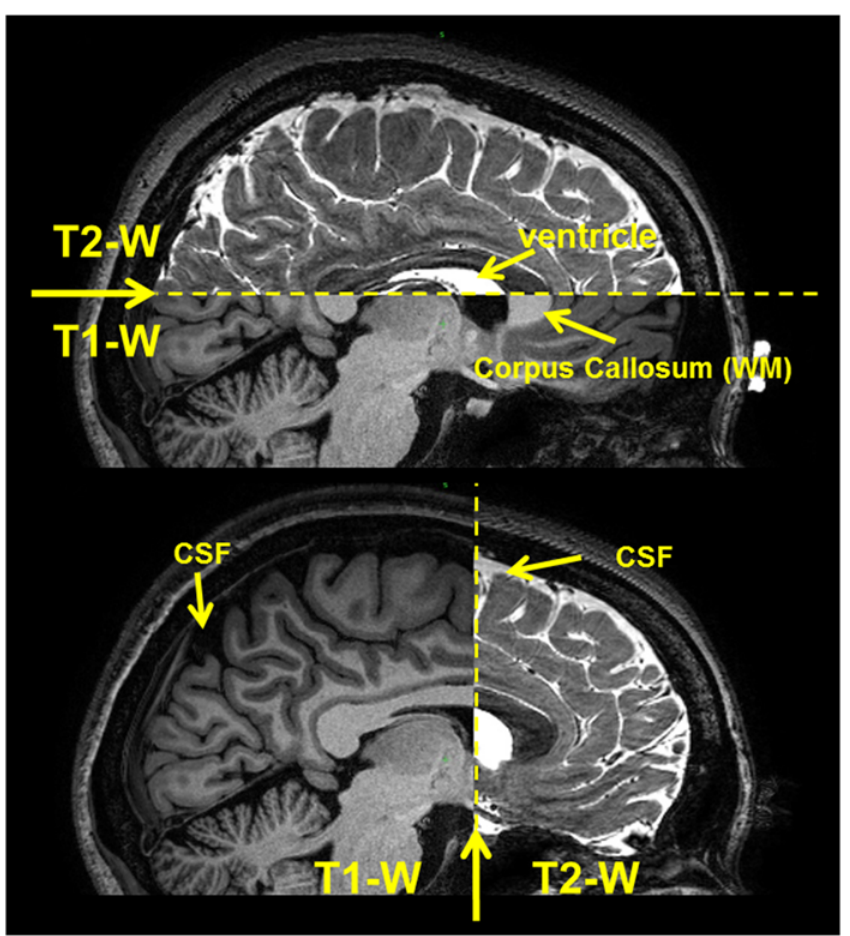
Fig 3. T1- and T2-weighted MRI registration. Sagittal view of the registered and integrated T1- and T2-weighted MRIs. The contrast between WM, e.g., corpus callosum, and GM signals is higher in T1, while the CSF, e.g., ventricle, is enhanced in T2. The tissue segmentation was performed by reaping the benefits of both MRI